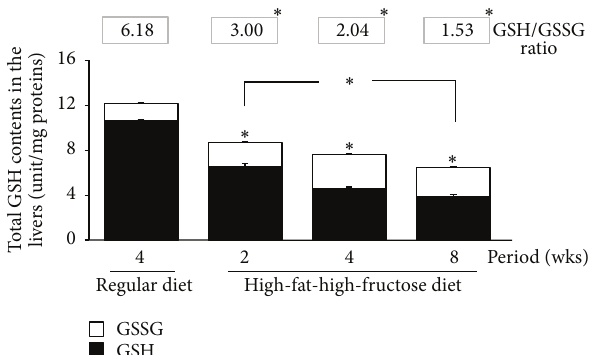
Figure 4: Effects of a high-fat, high-fructose diet on the total GSH, reduced GSH, and GSSH content and the GSH/GSSG ratio in the mouse livers.Micewerefedacommercialstandarddietfor4weeks,andahigh-fat,high-fructosediet(HFFD)wasadministeredintragastricallyfor2, 4, or 8 weeks. The mice were sacrificed 24 h after the last treatment, and their livers were immediately excised to examine the total glutathione, reduced GSH (black column), and GSSG (white column) contents, and the GSH/GSSH ratio was calculated (digit above the graph). The data are presented as the mean ± SD ( 𝑛 = 5 ). Significant differences were determined using a one-way analysis of variance (ANOVA) followed by Tukey’s post hoc test. ∗ 𝑝 < 0.05 versus the regular diet mice.